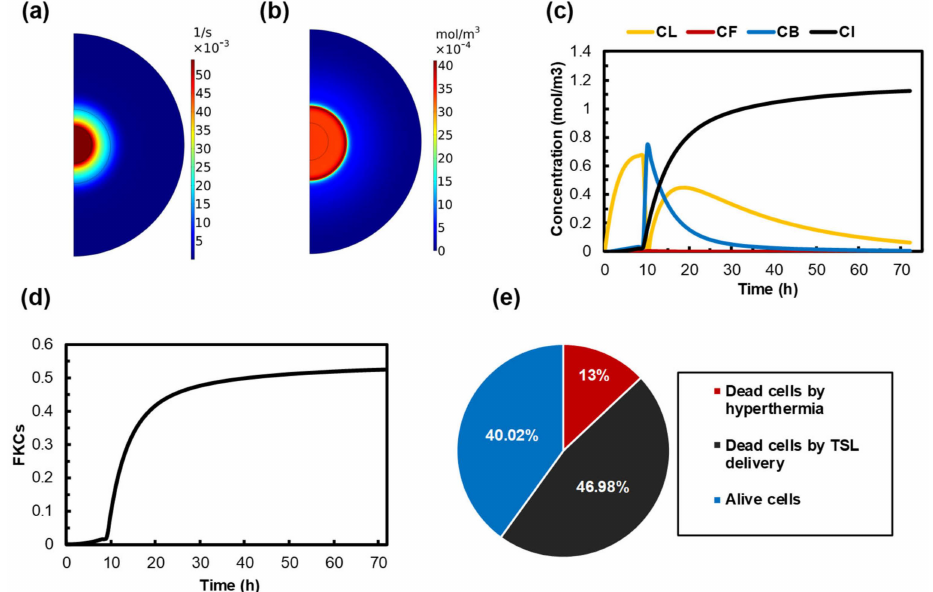
Figure 5. Treatment outcomes of MHT combined with TSL-Dox delivery by using 100 nm TSLs in a tumor with 200 nm vessel wall pore diameter. MHT is performed 9 h after TSL-Dox administration. ( a ) The release rate profile as a result of MHT. ( b ) Spatial distribution of free doxorubicin in the extracellular space of the tumor after MHT. ( c ) The concentration of TSL-Dox and free, bounded, and internalized Dox over time. The concentration of TSLs rapidly decreases after 9 h, because TSLs release the drug in response to temperature elevation. A dissimilar trend is shown for the concentration of bound and internalized drugs. ( d ) FKCs induced by release drug over time. ( e ) The effect of each part of the treatment on the final